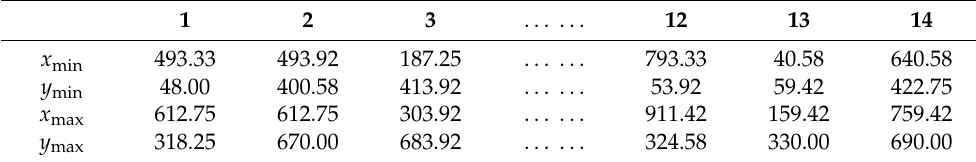
Table 2. Positions of random vehicle numbers.